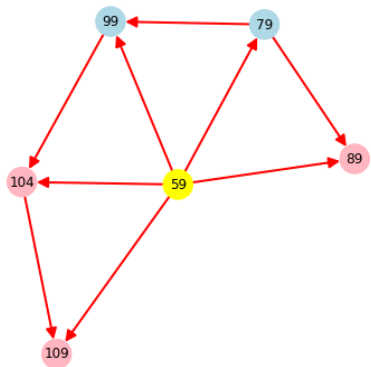
Figure 23. The fault propagation path when t = 1236 min in Mode 3 (yellow: root cause; red: rise or step up; blue: fall or step down).